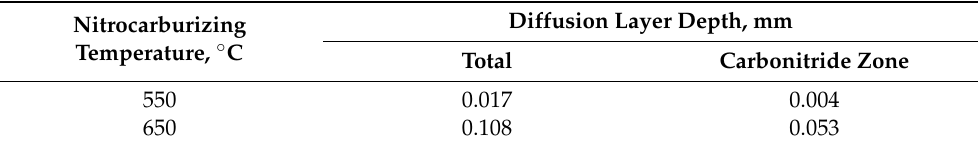
Table 4. Dependence of the diffusion layer depth on the nitrocarburizing temperature with a duration of 1 h for steel